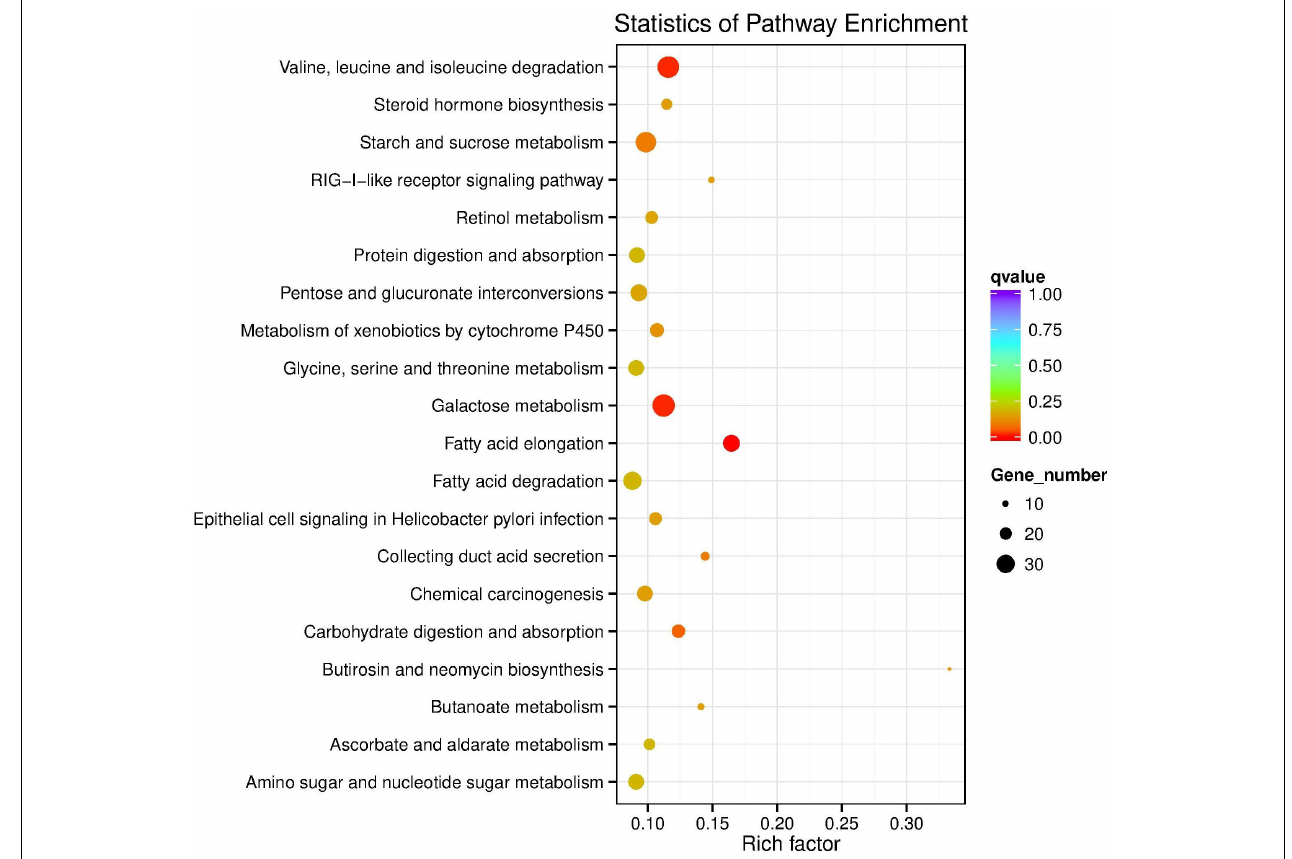
FIGURE 3 | KEGG pathway enrichment scatter plot. The vertical axis represents the path name, and the horizontal axis represents the path factor corresponding to the Rich factor. The size of the q -value is represented by the color of the point. The smaller the q -value, the closer the color is to the red color. The number of differential genes included in each pathway are expressed by the size of the point. (Top 20 enriched pathways are represented in scatter plot).